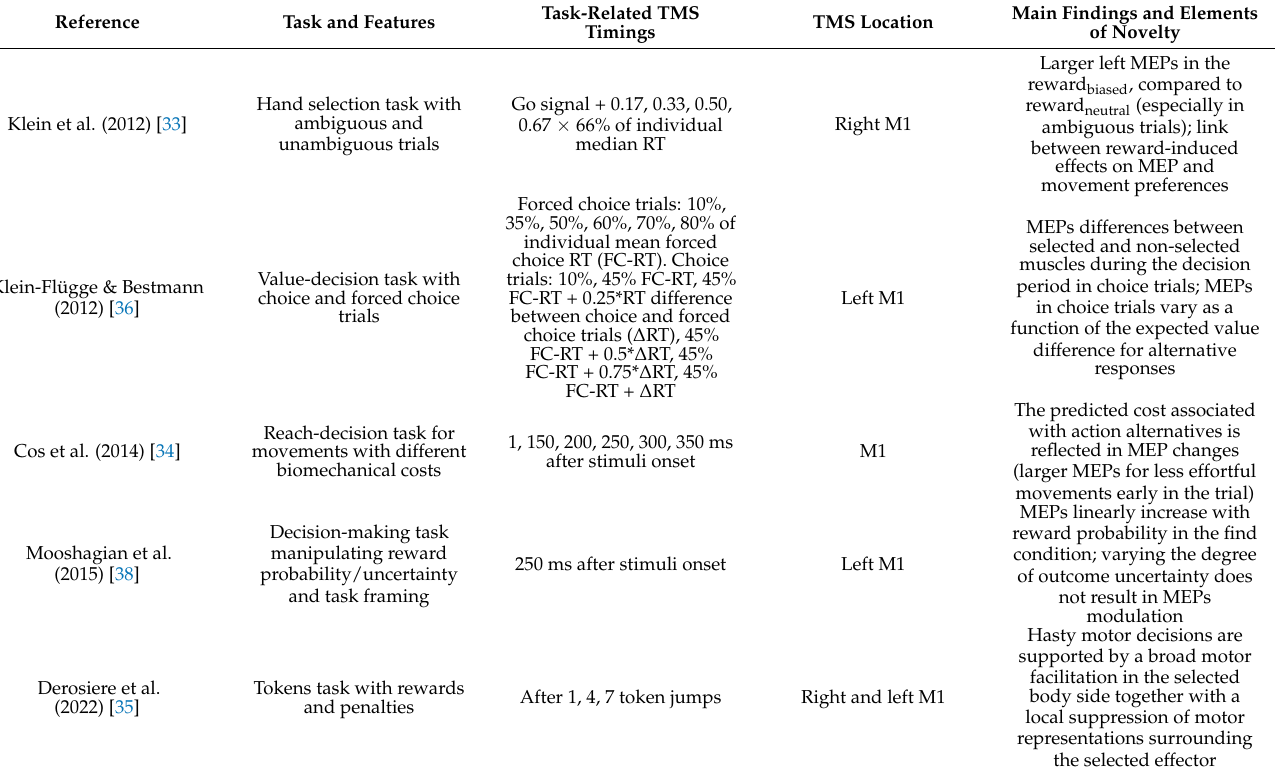
Table 3. Characteristics of key studies using TMS in motor decision